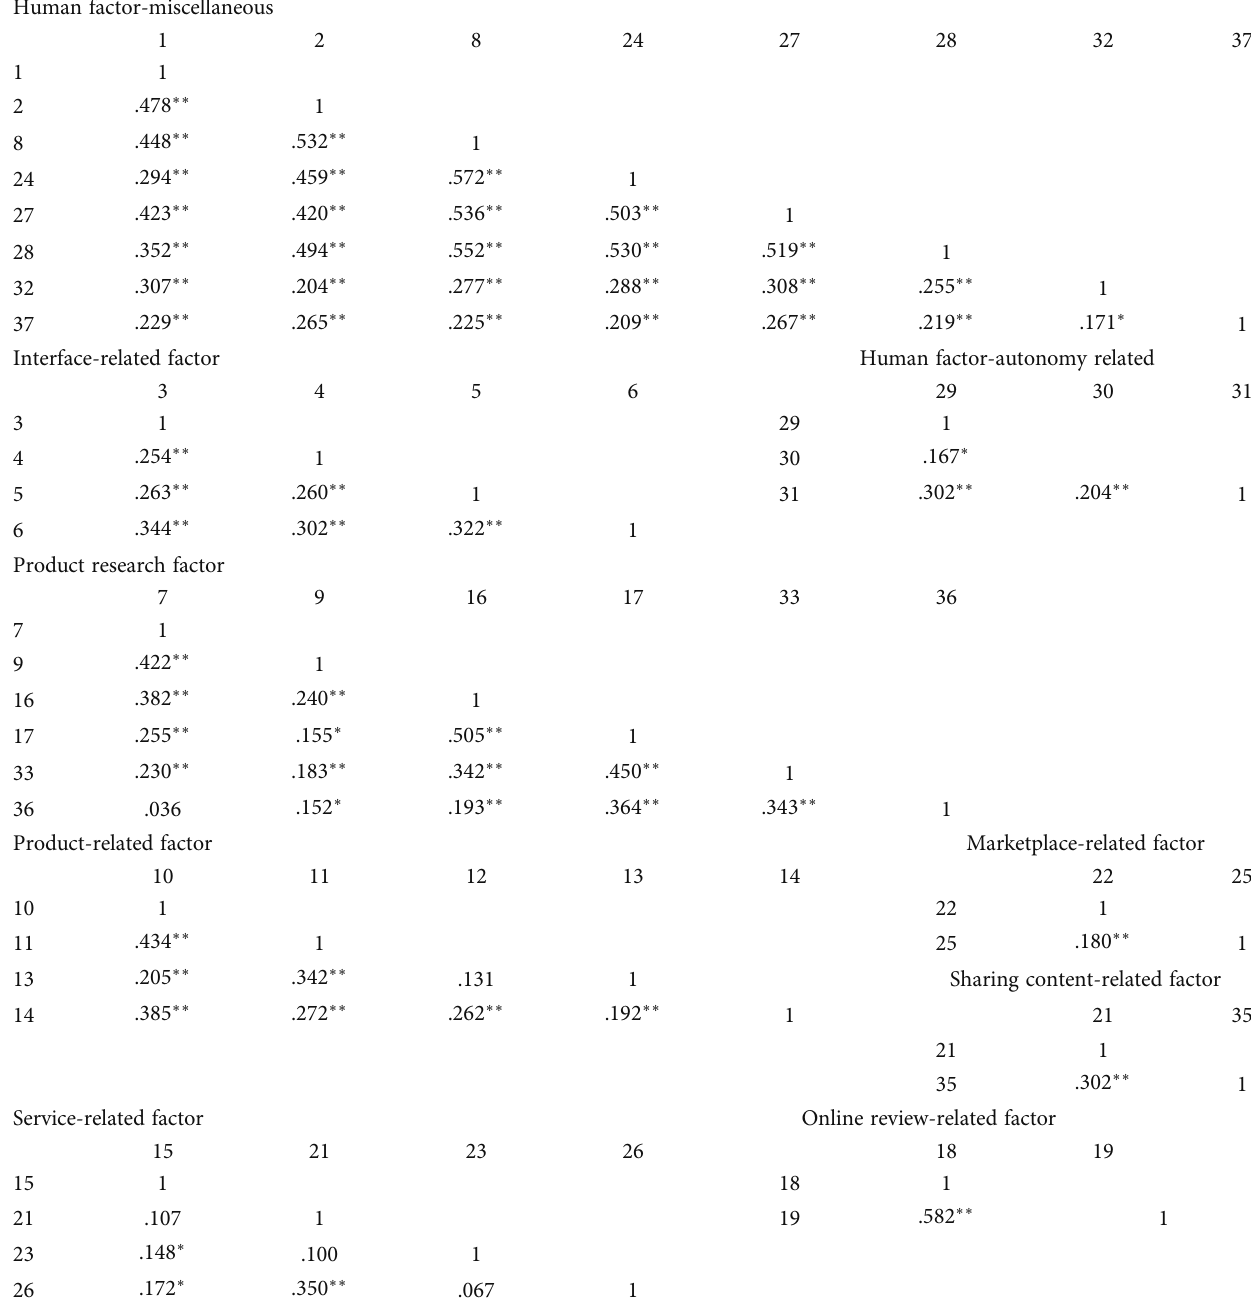
Table 4: Pearson correlations between indicators of each